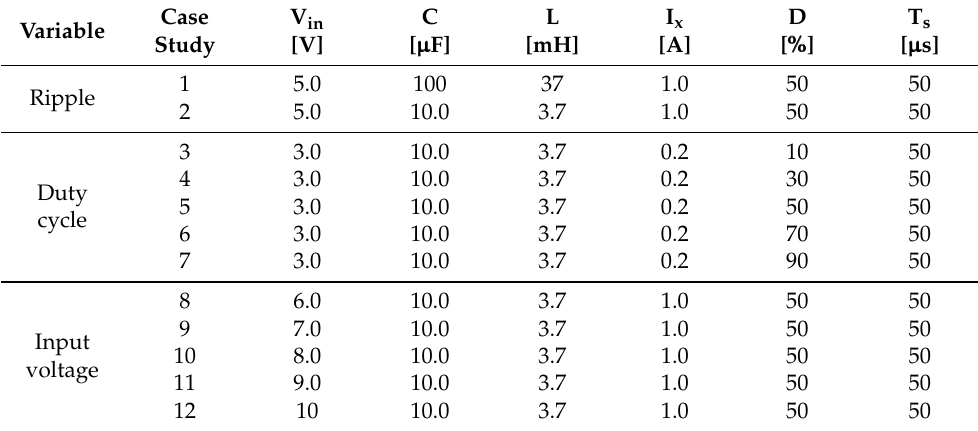
Table 1. Circuit values of the proposed converters.